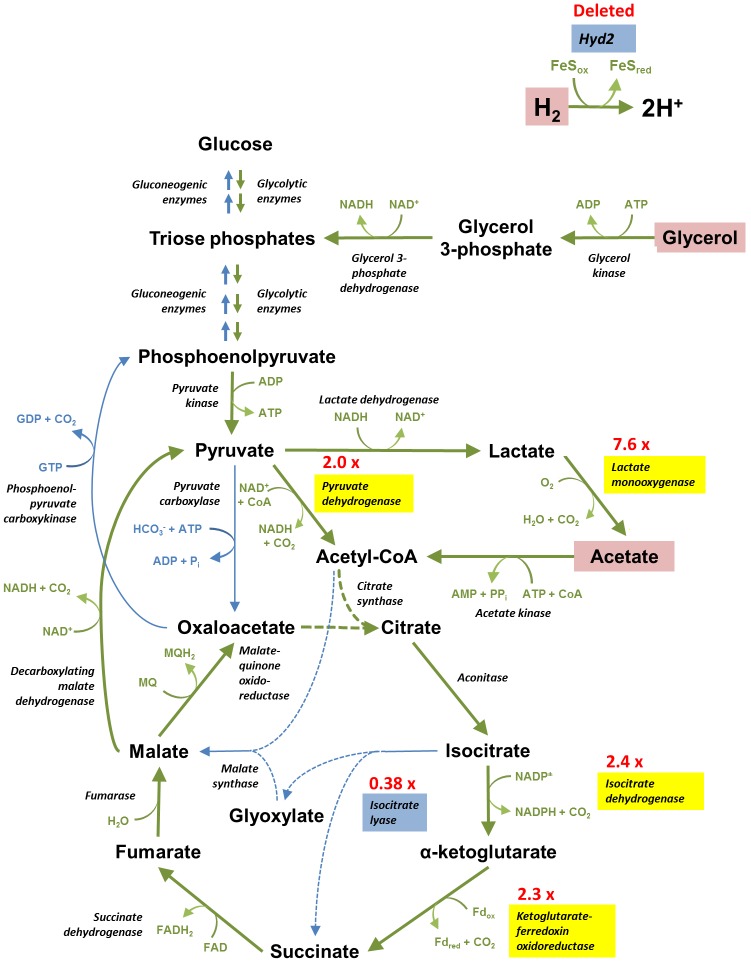
Altered balance of catabolic/anabolic carbon metabolism in Δhyd2 cells.Cells lacking Hyd2 compensate for the loss of electrons derived from H2 by increasing oxidation of organic carbon sources. There is an increased flux though the tricarboxylic acid cycle due to upregulation of enzymes involved in oxidative decarboxylation (e.g. ketoglutarate-ferredoxin oxidoreductase) (highlighted in yellow) and downregulation of those involved in anaplerosis (i.e. isocitrate lyase) (highlighted in blue). We model that loss of CO2 through oxidative decarboxylation reactions is principally responsible for the decreased biomass of Δhyd2 cells. Oxidative pathways are depicted with green arrows, whereas reductive pathways are represented with blue arrows. The red text shows the expression ratios of the significantly upregulated or downregulated genes in Δhyd2 vs. wild-type cells.